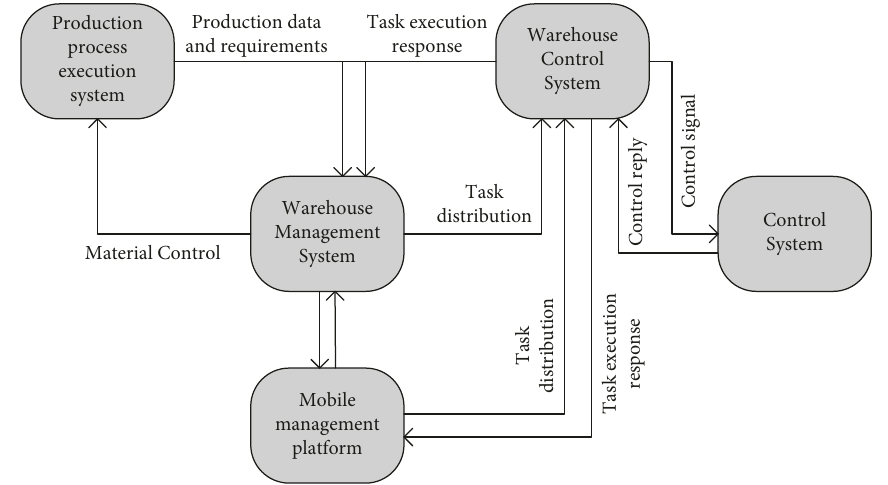
Figure 1: The composition of intelligent storage